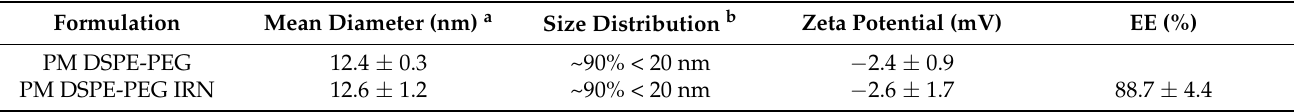
Table 1. Physicochemical properties of the different polymeric micelles